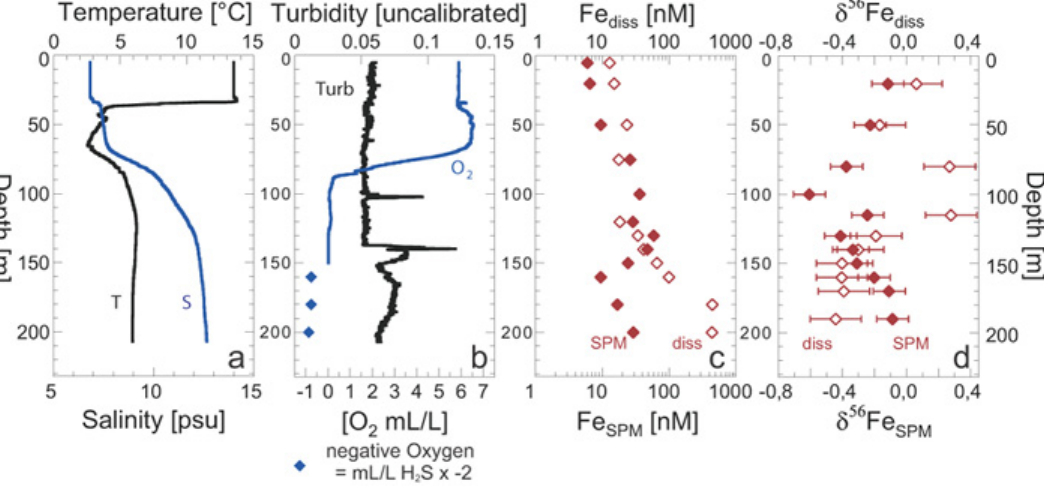
Fig. 2. Water column profile data for the Eastern Gotland Deep, central Baltic Sea, during October 2005: (a) temperature and salinity; (b) turbidity sensor data and dissolved oxygen concentration, with H 2 S presented as negative oxygen (Grasshof et al., 1983); (c) concentration of soluble and suspended particulate Fe; (d) Fe isotope ratios ( δ 56 Fe) of soluble and suspended particulate Fe, with error bars the respective external reproducibility calculated from